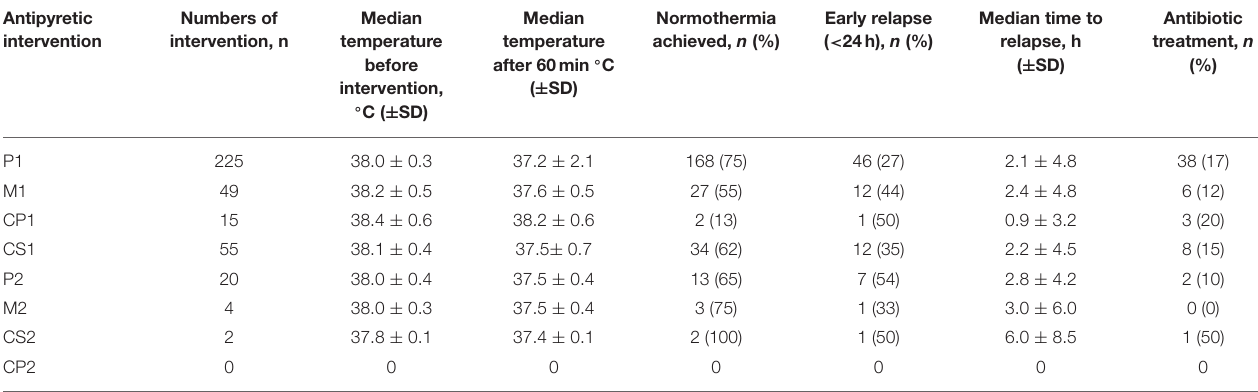
TABLE 3 | Effects of sequential antipyretic interventions ( n = 370) in 130 febrile patients. Antipyretic intervention